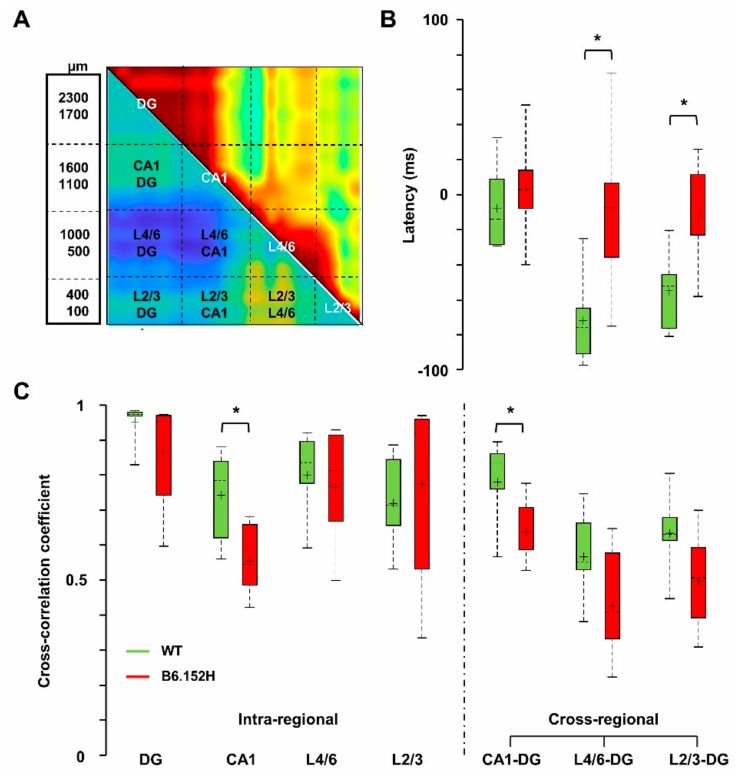
Figure 6. Loss of SO cortico-hippocampal correlation and latency in young B6.152H mice. For quantitative analyses of regional changes, SO maximal cross-correlation coe ffi cients and latencies of each mouse were averaged within (intraregional) and between (cross-regional) regions, according to the scheme overlaid to the matrices of the three-month-old WT mice ( A ). Values were then averaged by age and genotype and shown in boxplots as cross-regional latencies ( B ) and intra- and cross-regional cross-correlation coe ffi cients ( C ), * p <